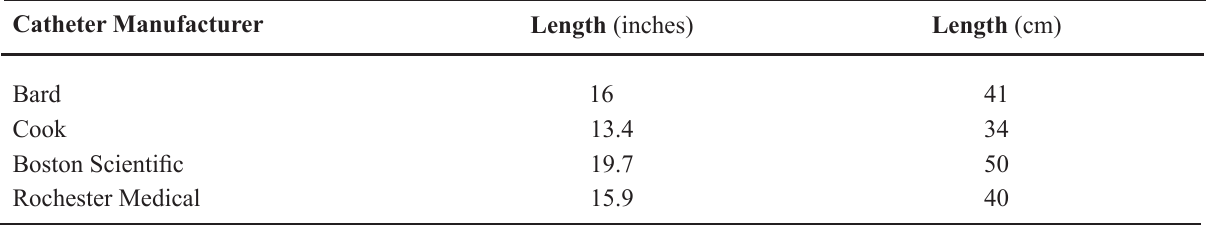
Table 3 – Catheter lengths for 16F adult catheters. Catheter